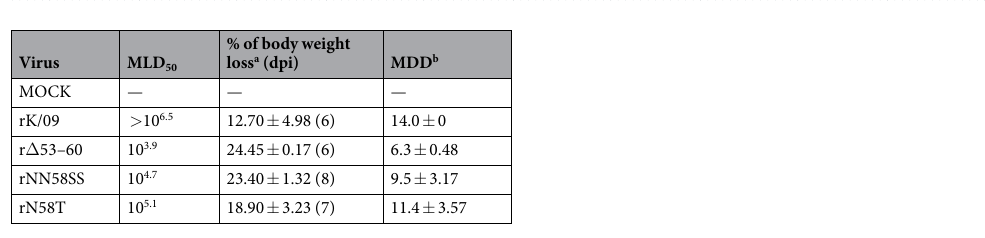
Figure 3. Body weight changes and survival rates of the mice infected with the rK/09 and its NA stalk mutant viruses. Ten mice per group were intranasally infected with ( A ) 10 4 , ( B ) 10 5 , and ( C ) 10 6 PFU of the rK/09, ma - P5, r Δ 53–60, rNN58SS, and rN58T viruses, respectively. Body weight changes and survival rates of the infected mice were represented in average. Mice in the mock group were infected with PBS. Error bars denote SD. ( * P < 0.05, ** P < 0.01, and *** P < 0.001 compared with the results of rK/09 infection group).